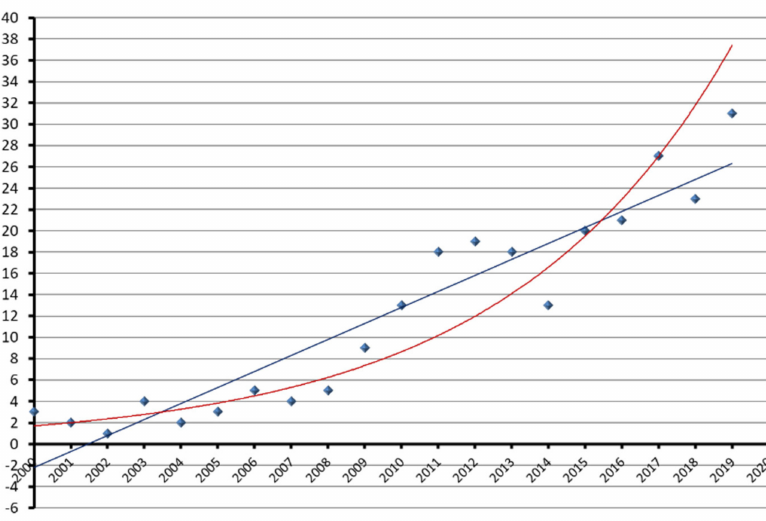
Figure 2. Chronological distribution of scientific Production. Linear adjustment (blue): y = 1.5015x – 3005.2 ( r = 0.8856). Exponential adjustment (red): y = 8E-142e 0.1627x ( r = 0.8695).